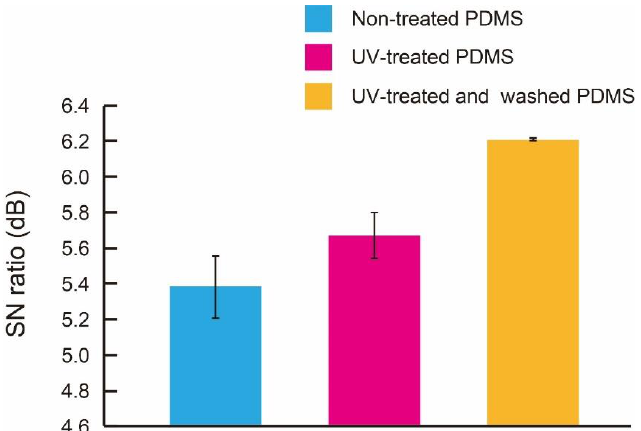
Figure 10. SN ratio obtained from nine devices, the nontreated devices, UV-treated devices, and the UV-exposed and washed devices (n =